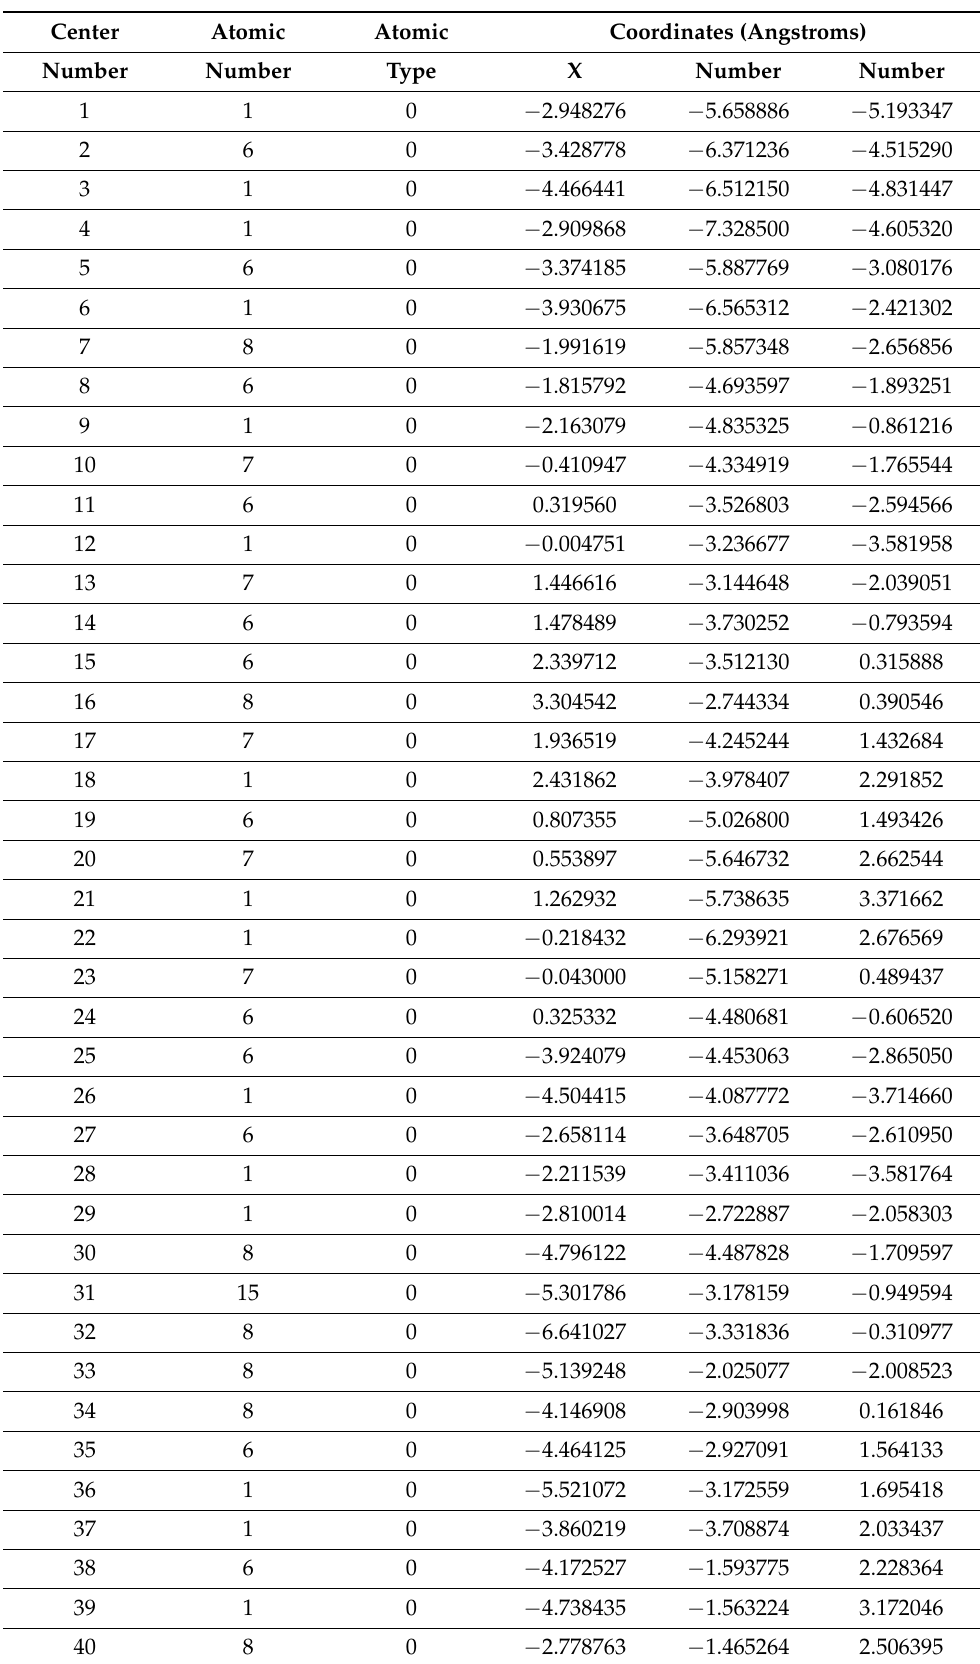
Table A11. Complex MgI 3 LiII 2 with nucleotide triplet CGG. Standard